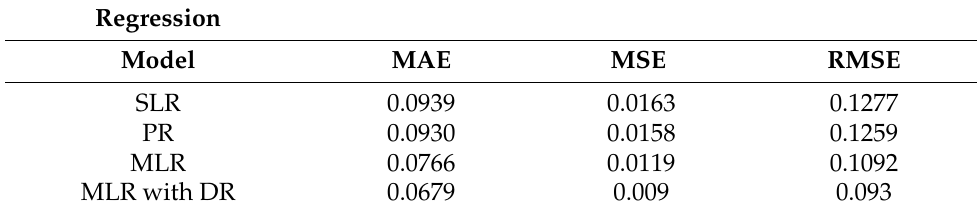
Table 12. Comparison of regression models’ performance on testing dataset.